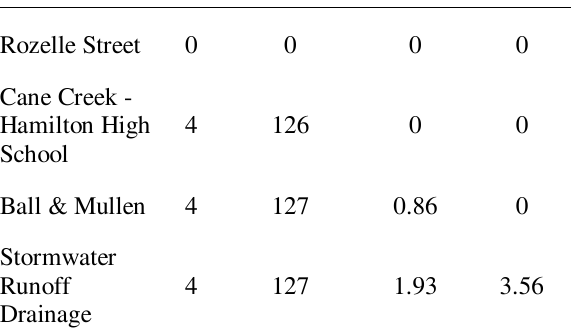
Table 1: Atomic Absorption Analysis Results*